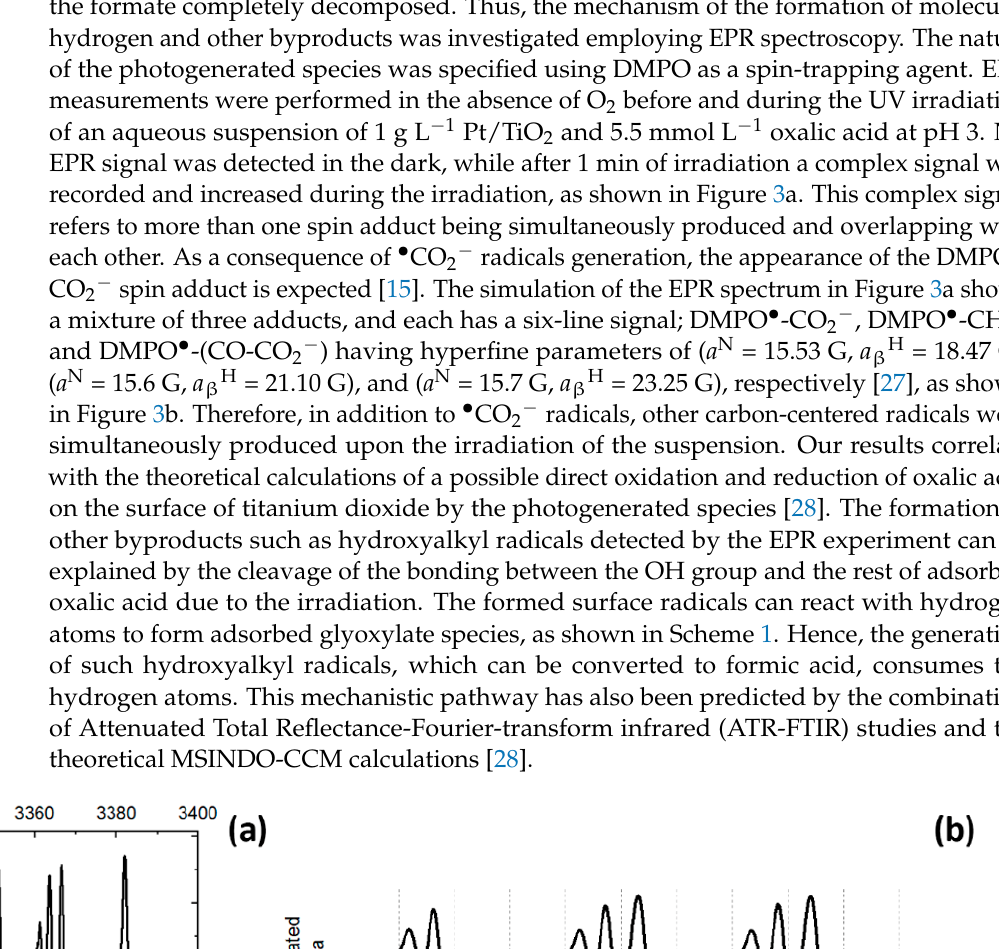
Scheme 1. The mechanism proposed for the cleavage of C–O bonds before the addition of hydrogen atoms to produce adsorbed aldehyde molecules. Adapted from [15,28], copyright 2020, American Chemical Society. Based on the discussed results and on the EPR investigations, the degradation of ox- alic acid on the surface of TiO 2 can be accomplished through different pathways. Here, hydrogen oxalate HC 2 O 4 − is dominant in the suspension at pH 3 (pK a1(OA) = 1.25) [29]. These species adsorb on the surface of TiO 2 and react directly with the photogenerated holes [28] to produce hydrogen oxalate radicals HC 2 O 4 • (Equation (2)). These radicals can also be produced through an indirect hole transfer oxidation by the hydroxyl radicals generated on the titanium dioxide surface (Equation (3)) [30,31]. Through a photo-kolbé reaction mechanism, hydrogen oxalate radicals are further degraded to form CO 2 and carbon di- oxide anion radicals • CO 2 − via the formyloxyl radical HCO 2 • (Equation (4)). • CO 2 − are highly reductive radicals (E 0 = − 2.0 V) [32], and they have been shown to induce the cur- rent doubling effect (Equation (5)) through the injection of their electrons in the conduc- tion band of TiO 2 [33]. • CO 2 − radicals can also initiate the formation of formate, either by